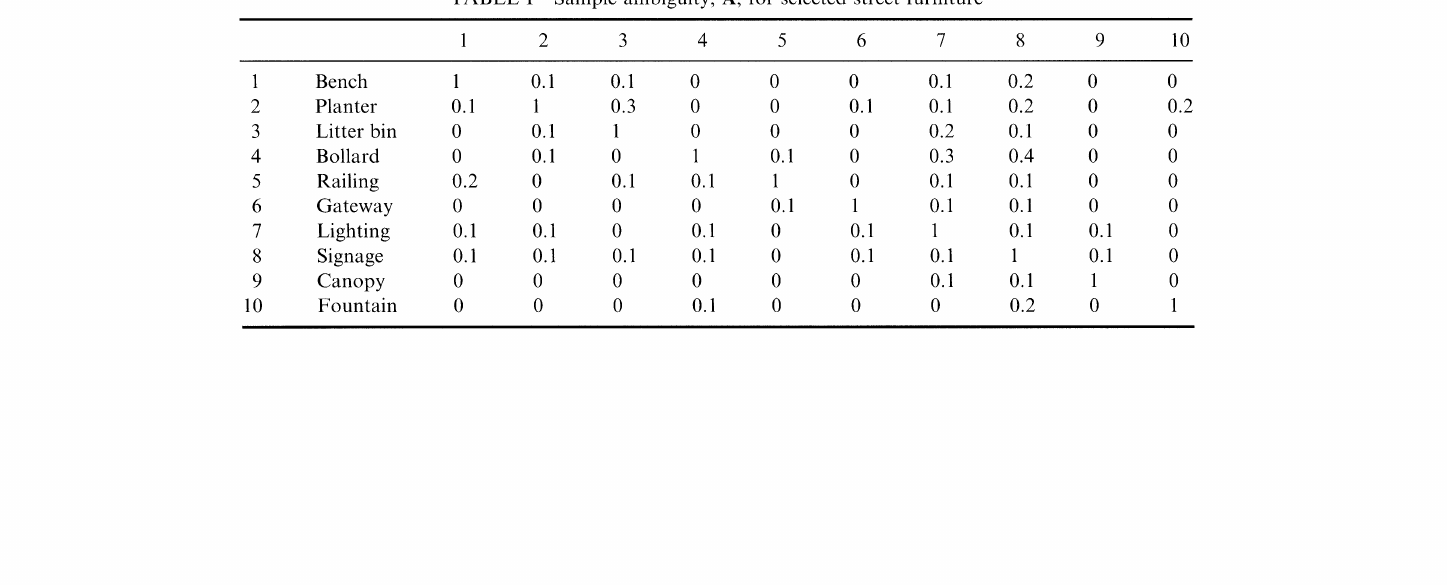
Sample ambiguity, A, for selected street